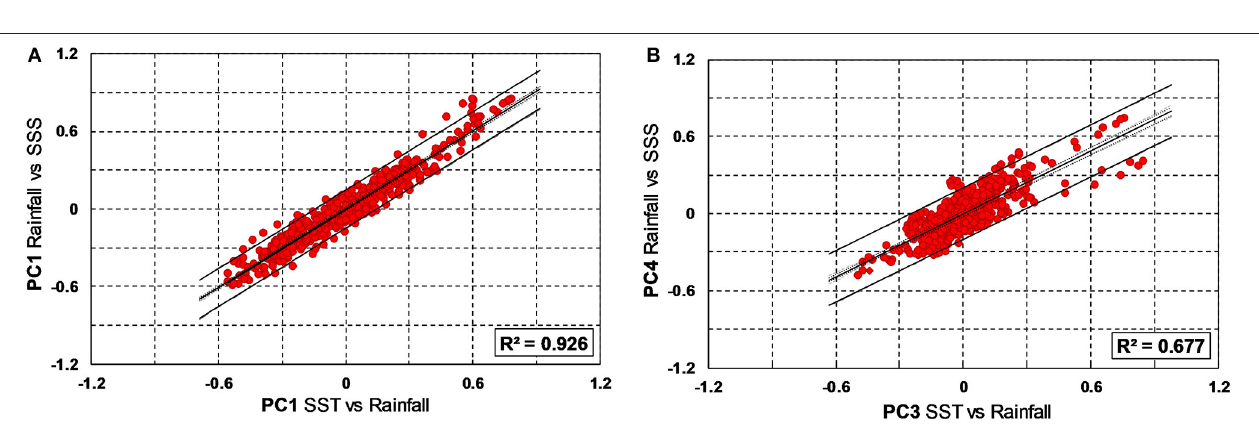
FIGURE 8 | Linear regression between (A) the first PCs of EOF rainfall vs. SSS by EOF SST vs. rainfall and, (B) the fourth PC of EOF rainfall vs. SSS by the third PC of SST vs. rainfall, both at 95% confidence level.